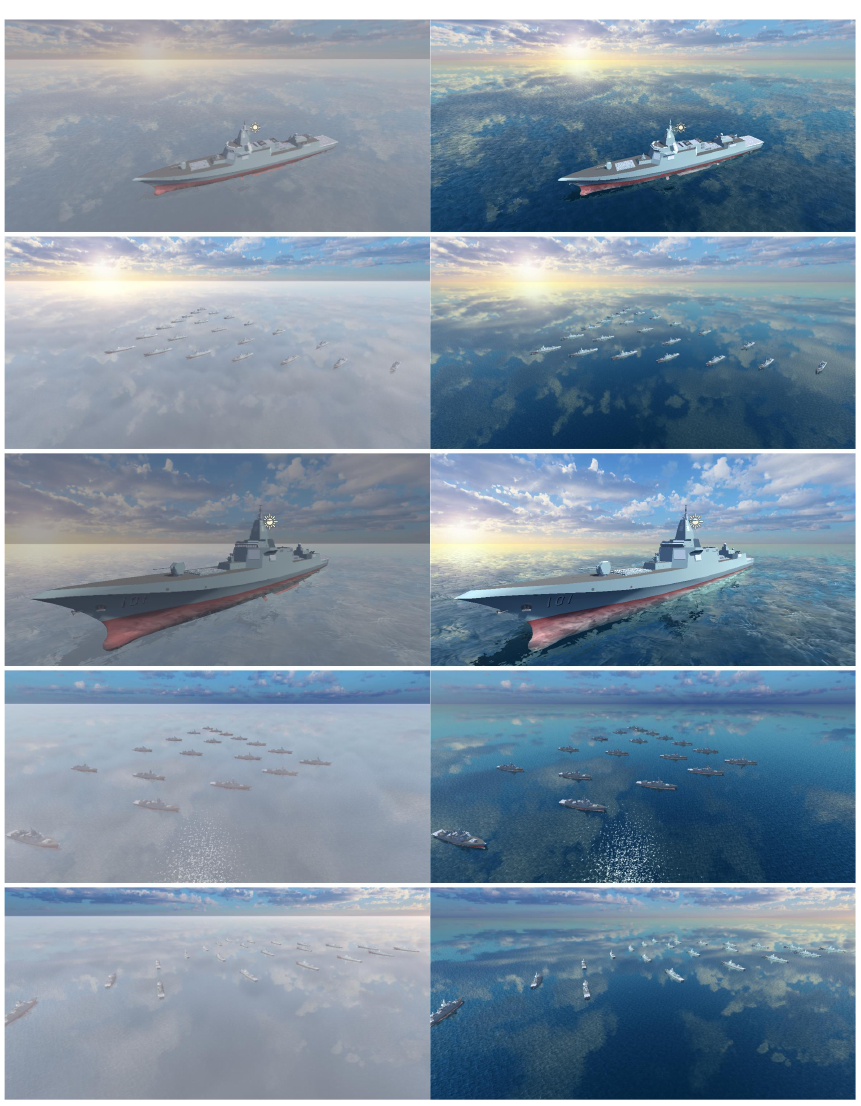
Figure 5. Samples of datasets. Left: Hazy input. Right: Ground-truth. The datasets contain multi targets and a variety of situations to be as realistic as